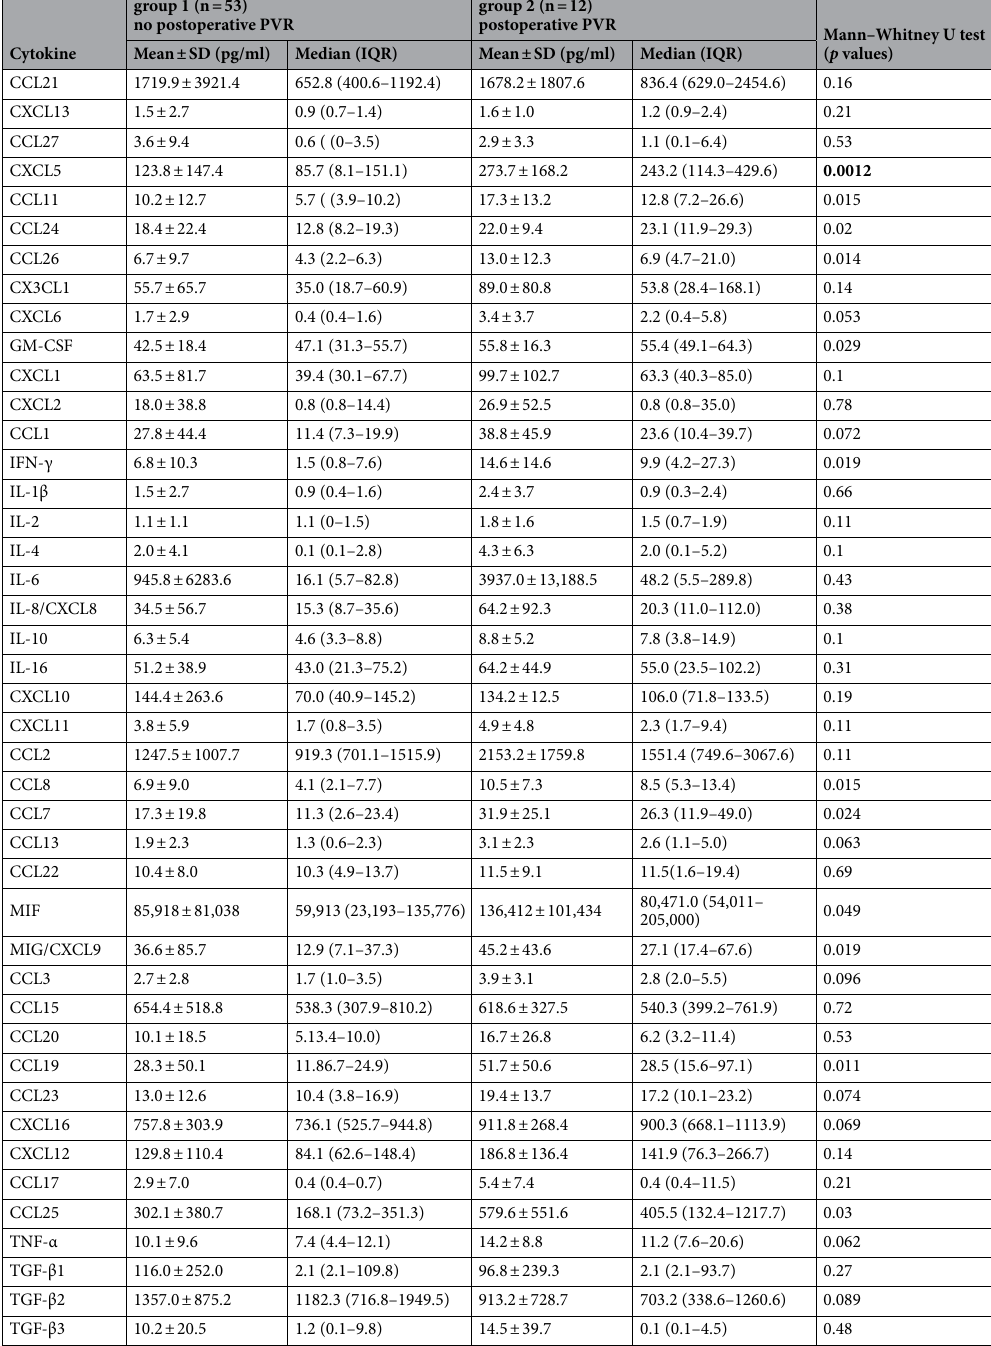
Table 2. Mean concentrations (pg/ml) and standard deviations (SDs), as well as medians and interquartile ranges (IQRs) of cytokines in the vitreous of RRD eyes without PVR and without PVR development after surgical intervention (group 1) and eyes with PVR development after surgery (group 2). p Values which remain significant after Holm correction are marked in